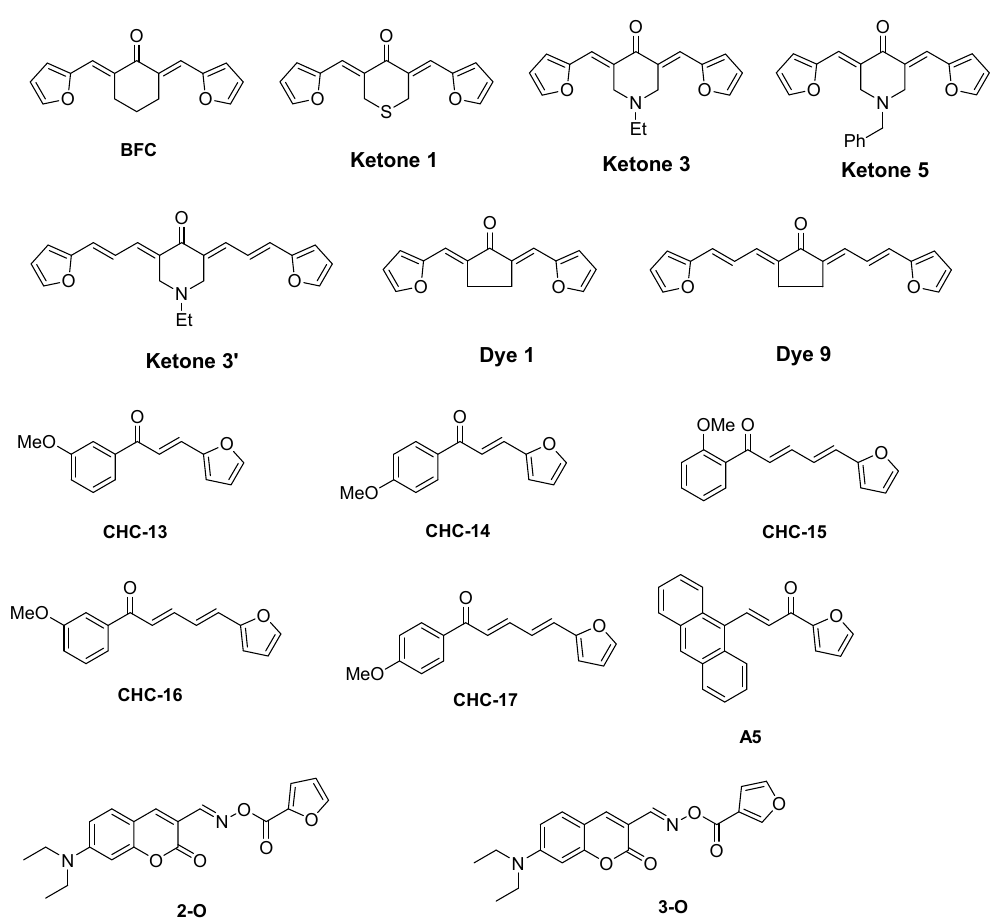
Figure 24. Chemical structures of the different furan-based compounds reported in this review.